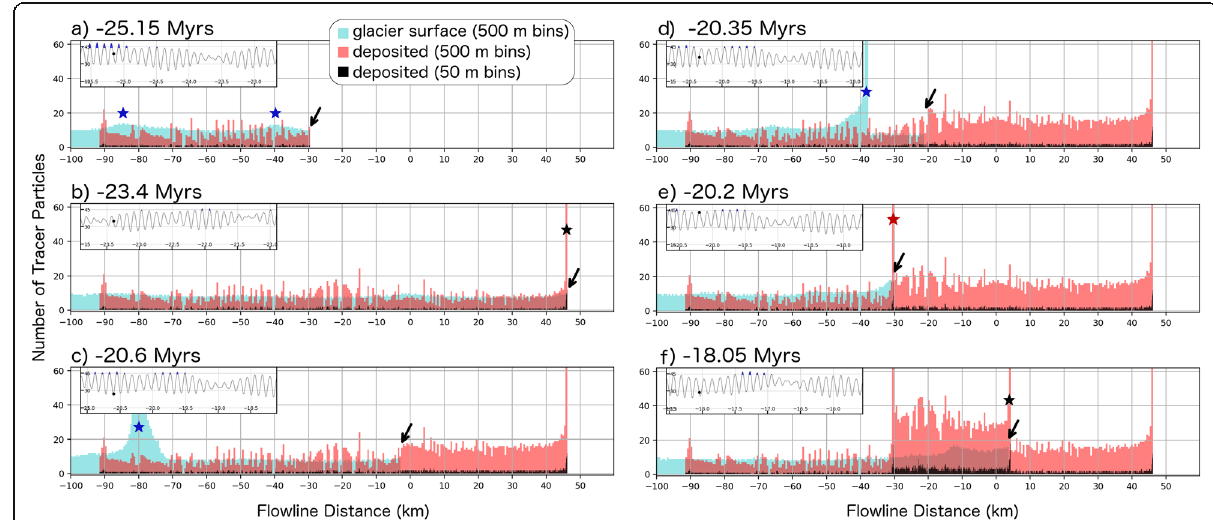
Fig. 13 Ridge formation modeled by advection of tracer particles placed on the simulated ice sheet. Blue and red histograms give the number of tracer particles on the ice sheet surface and deposited on the substrate, respectively using a 500 m bin size (resolution of PISM simulations). Particles are individually placed at the − 100 km flow line position and are advected by the flowing ice. Once a particle has been transported 50 m, a new particle is placed at the − 100 km position. The black histogram gives the number of deposited particles using a 50 m bin size and represents the same data in the red